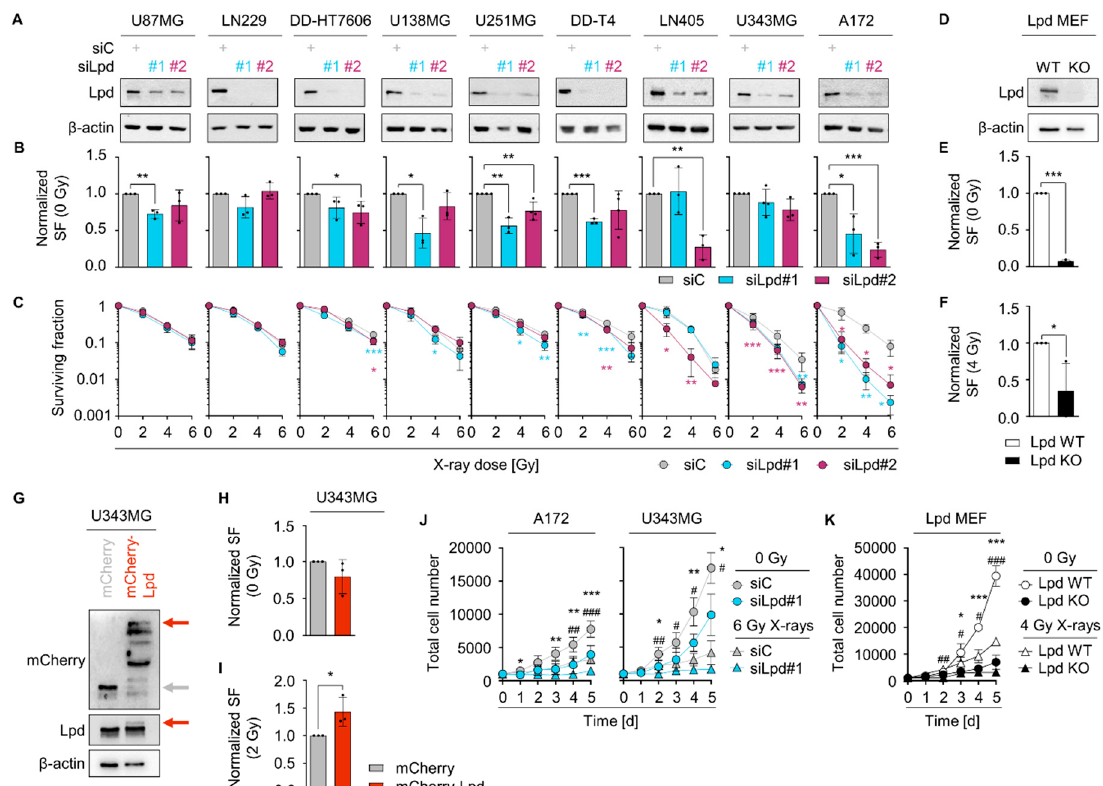
Figure 2. Lamellipodin regulates radiosensitivity and proliferation of glioblastoma cells. ( A ) Western Blot analysis of knockdown efficiency after transfection of Lpd-specific and control siRNA in indicated glioblastoma cell cultures. β -actin served as loading control. ( B ) Surviving fraction (SF) at 0 Gy relative to control knockdown and ( C ) clonogenic radiation survival upon 2, 4 and 6 Gy irradiation of Lamellipodin-depleted glioblastoma cell cultures after cell-line-dependent incubation times (7–15 days). ( D ) Western blot analysis of Lpd and β -actin expression in whole-cell lysates from Lpd WT MEF and Lpd KO MEF showing knockout efficiency. ( E ) Normalized surviving fraction at 0 Gy and ( F ) 4 Gy of Lpd KO MEF compared to Lpd WT MEF. ( G ) Representative Western blot analysis of transient mCherry-empty and mCherry-Lpd vector expression in U343MG. ( H ) Normalized surviving fraction at 0 Gy and ( I ) 2 Gy of mCherry-Lpd-expressing U343MG cells relative to mCherry-empty controls after 10 days. ( J ) Total cell number indicating proliferation of non-irradiated (circle) or 6 Gy-irradiated (triangle) A172 and U343MG cells after siRNA-mediated knockdown of Lamellipodin or control knockdown recorded at days 0 to 5. ( K ) Proliferation (total cell number) of non-irradiated (circle) and 4 Gy irradiated (triangle) Lpd WT MEF and Lpd KO MEF. All results show mean ± SD ( n = 3–4, two-sided Student’s t -test, */# p < 0.05, **/## p < 0.01, ***/### p < 0.001). * indicates p -values of non-irradiated and # indicates p -values of irradiated conditions in ( J , K ). si, small interfering RNA; C, control; Lpd, Lamellipodin; SF, surviving fraction; WT, wild type; KO, knockout; MEF, mouse embryonic